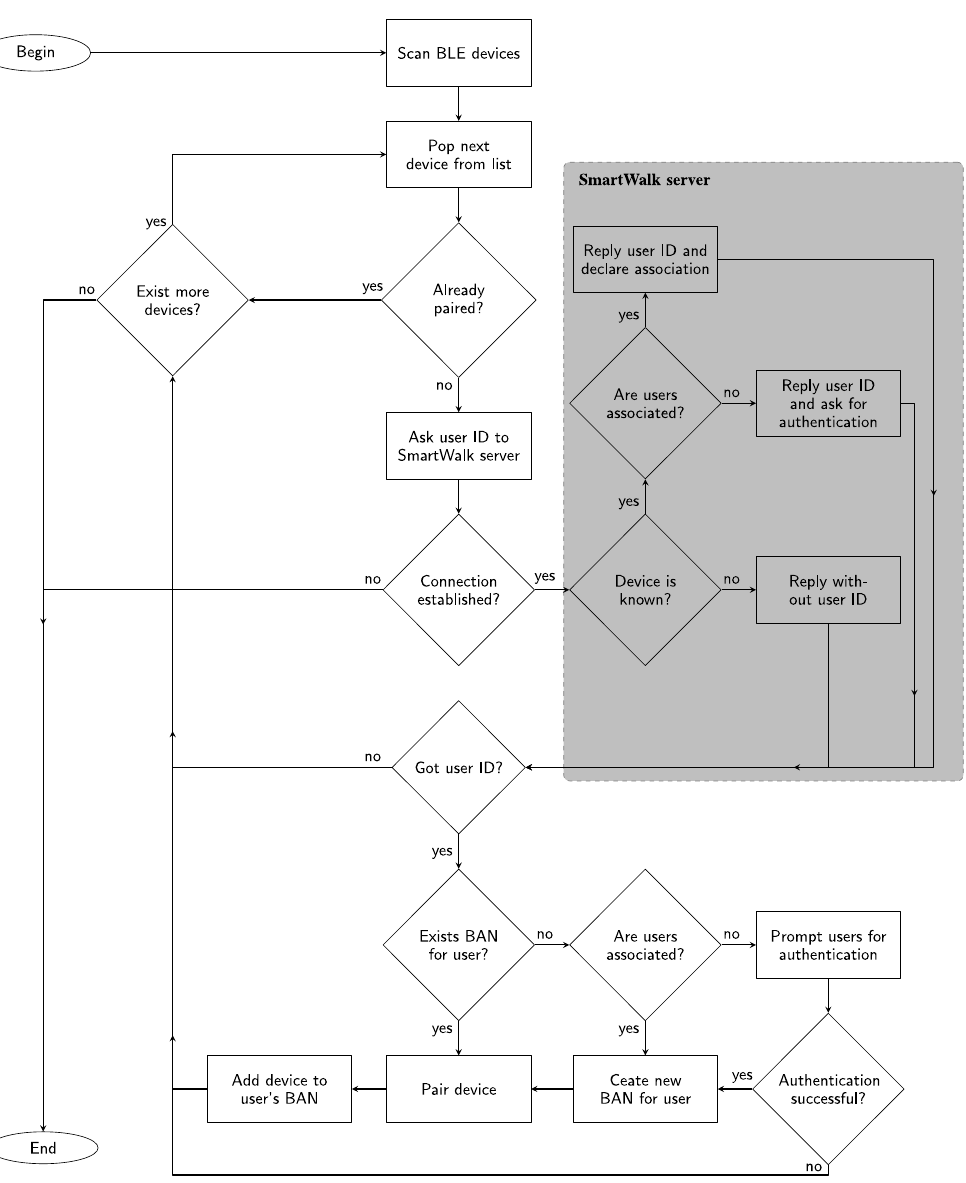
Figure 4. Algorithm to associate a BLE with a BAN.